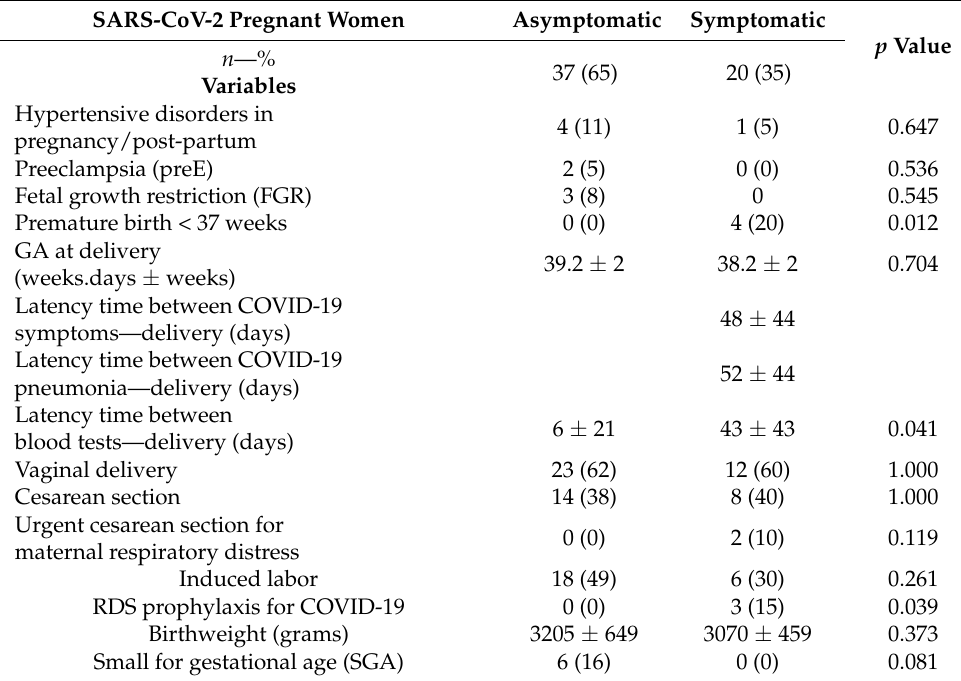
Table 4 shows obstetric outcomes comparing symptomatic vs. asymptomatic women at hospital admission. Table 4. Obstetric outcomes comparing symptomatic vs. asymptomatic women at the hospital admission [Mean; standard deviation—SD; n ;